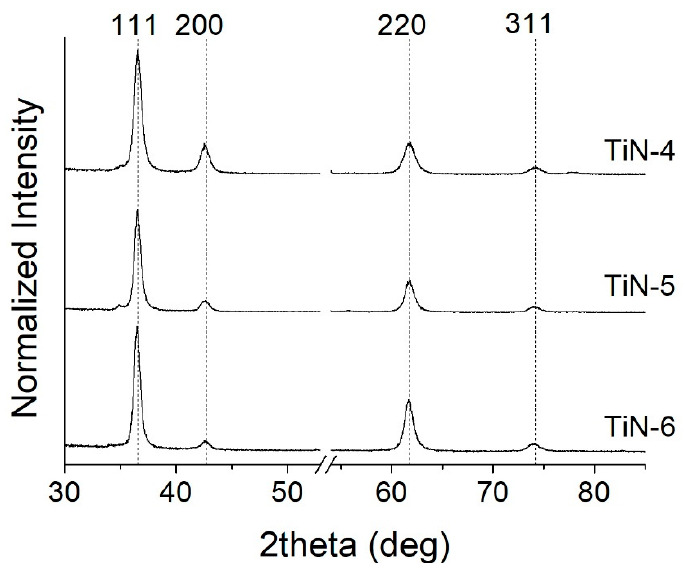
Figure 3. SEM micrographs of samples TiN4A deposited on alumina.